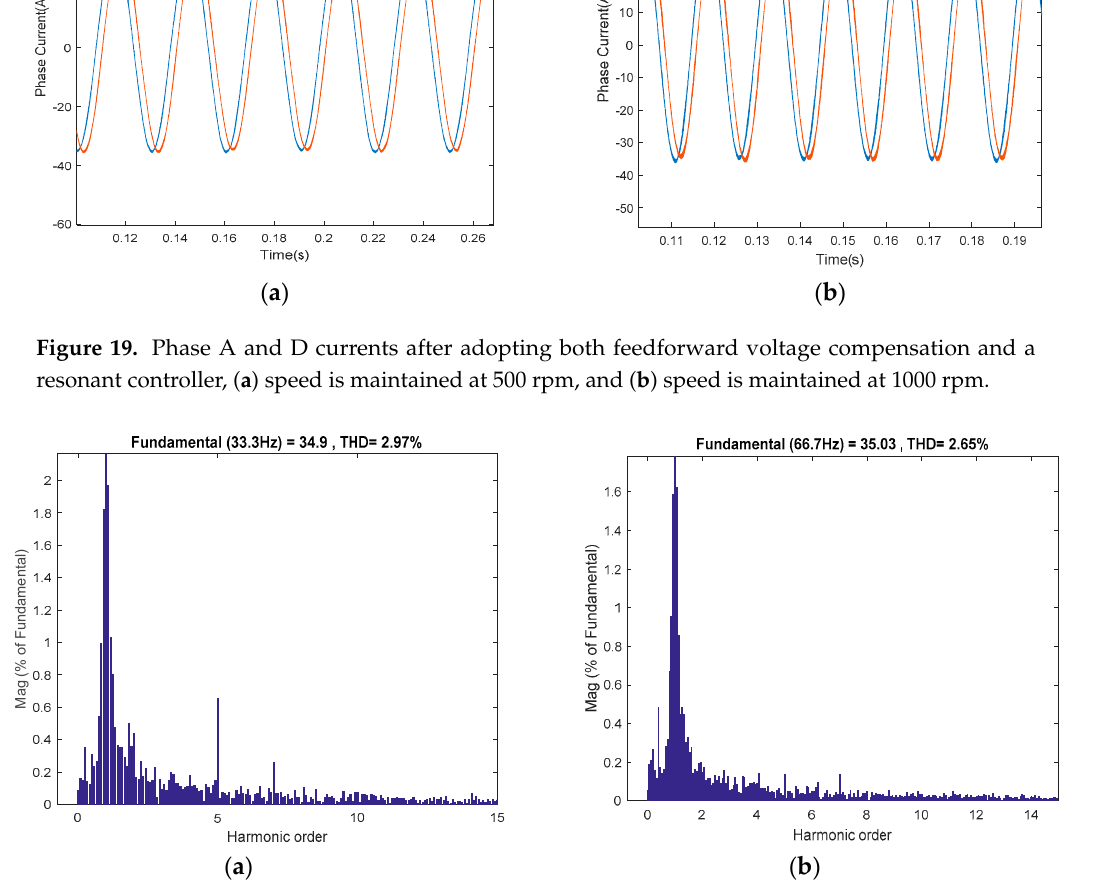
Figure 20. THDs of the phase A current after adopting both feedforward voltage compensation and a resonant controller, ( a ) speed is maintained at 500 rpm and ( b ) speed is maintained at 1000 rpm.